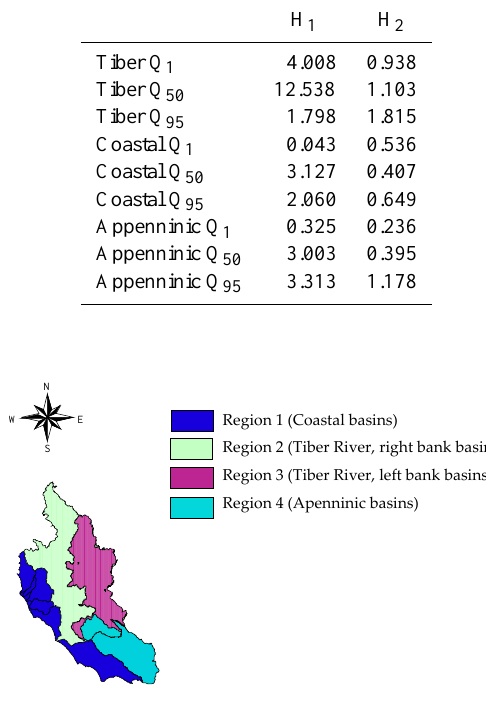
Fig. 5. Homogeneous regions recognized in the study area. Four regions were determined according to the geomorphological char- acteristics of the